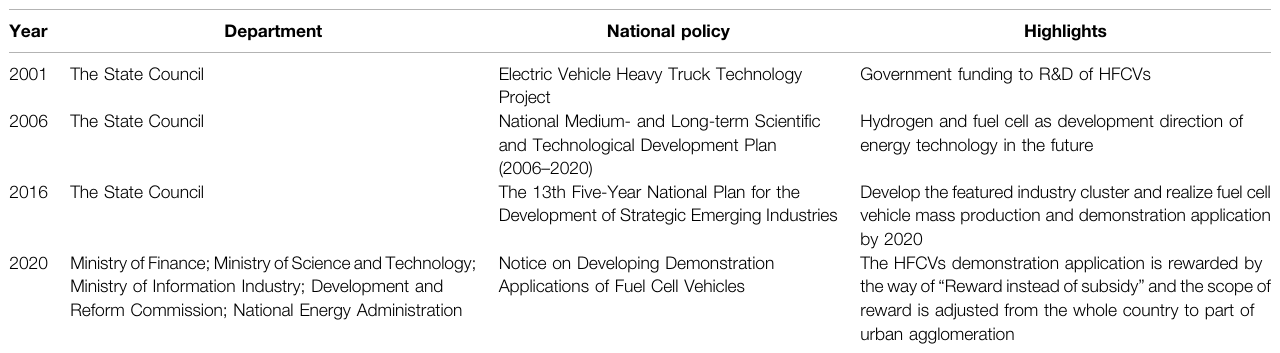
TABLE 2 | List of main national policies supporting the development of HFCV industry in China (2001 –